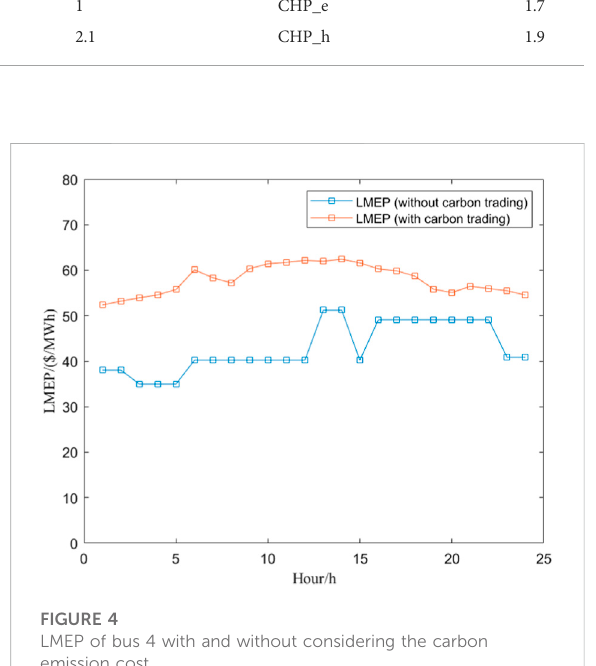
FIGURE 4 LMEP of bus 4 with and without considering the carbon emission